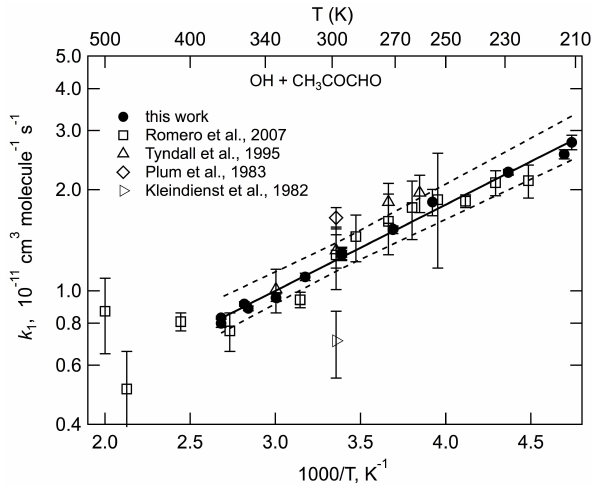
• ) from this work. The solid line (cid:12) (cid:12) (cid:12) (cid:12) − 1 ) g( 1 (cid:12) with (cid:12) T 298